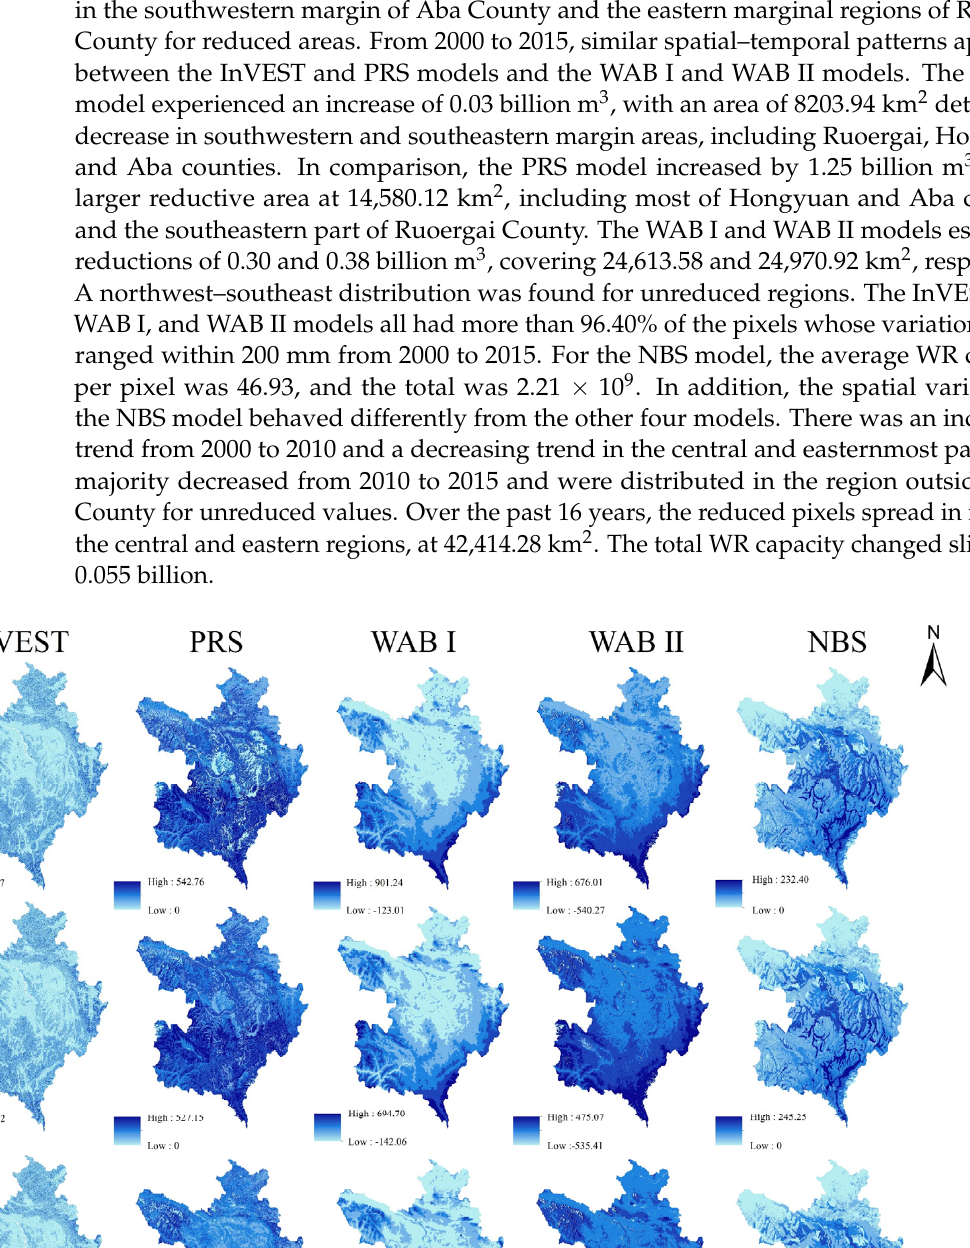
Figure 4. Spatial distribution of change trend values ( a – d ) and significance ( p < 0.05) ( e – h ) of